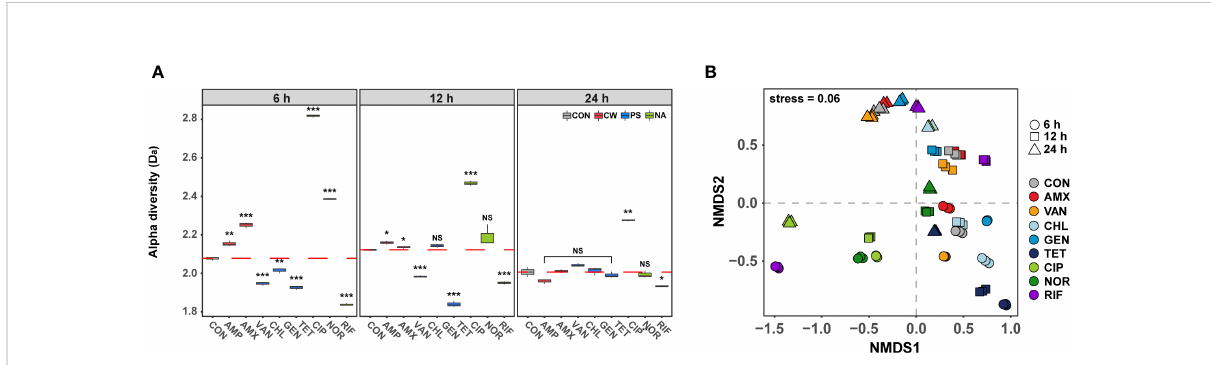
FIGURE 2 Differences in phenotype diversity between antibiotic treated samples over time by FSC-FITC data from fl ow cytometry. (A) Box plots depict alpha diversities (D a ) of live cell distribution by Shannon index. The red dashed line means the average of control. The difference was considered signi fi cant at a P-value (NS, P > 0.05; *P < 0.05; **P < 0.01; ***P < 0.001, t -test). (B) The phenotypic beta diversity (D b ) analysis of the fl ow cytometry data separating samples according to the antibiotic treatment by non-metric multidimensional scaling (NMDS) based on the Bray- Curtis distance metric.